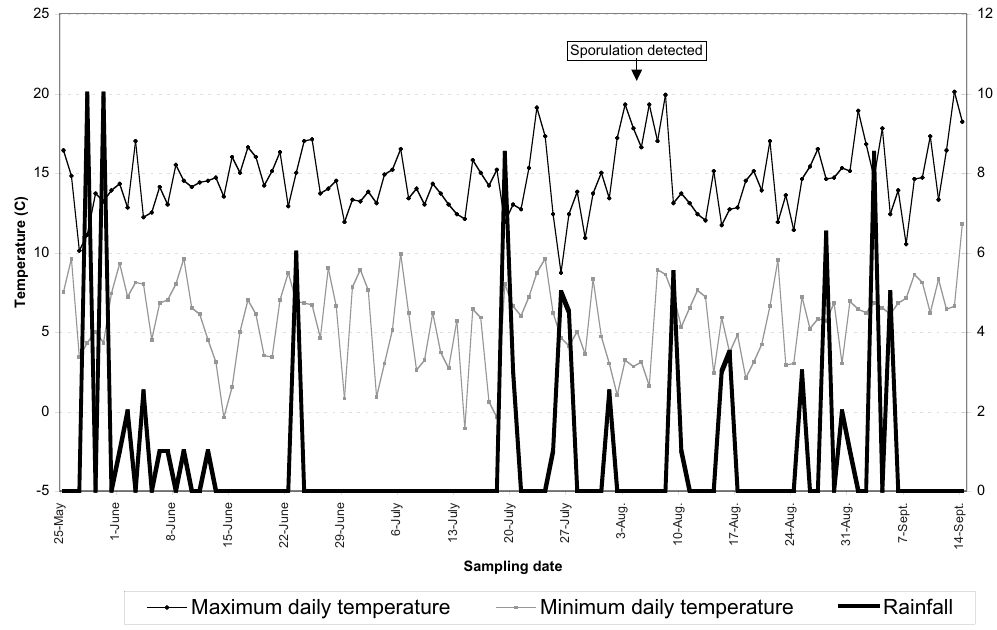
Fig. 3. Daily temperature (maximum and minimum) and rainfall over the duration of the trial (May to September 2000) and date of detection of Phaeomoniella chlamydospora